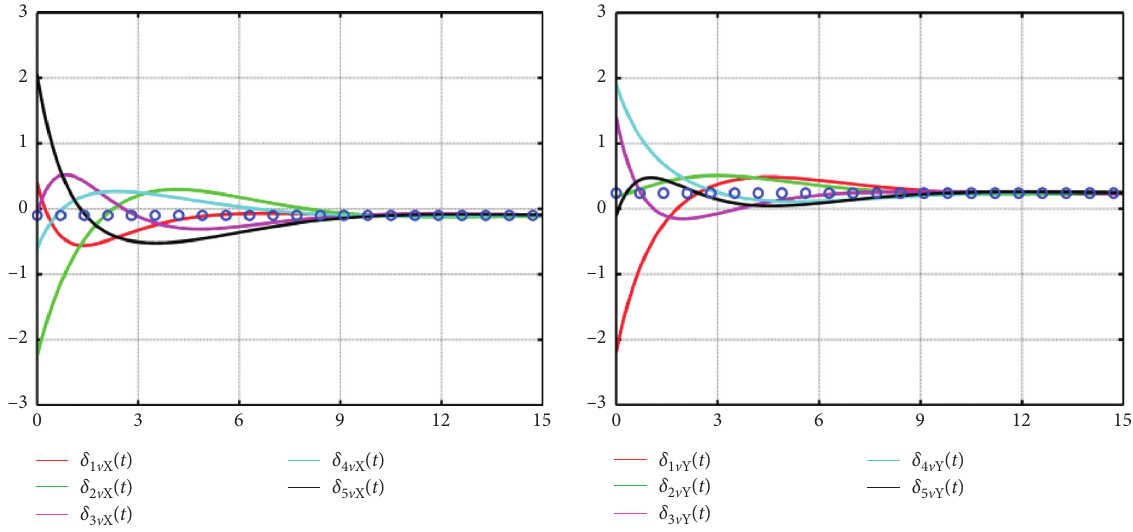
Figure 2: Trajectories of δ